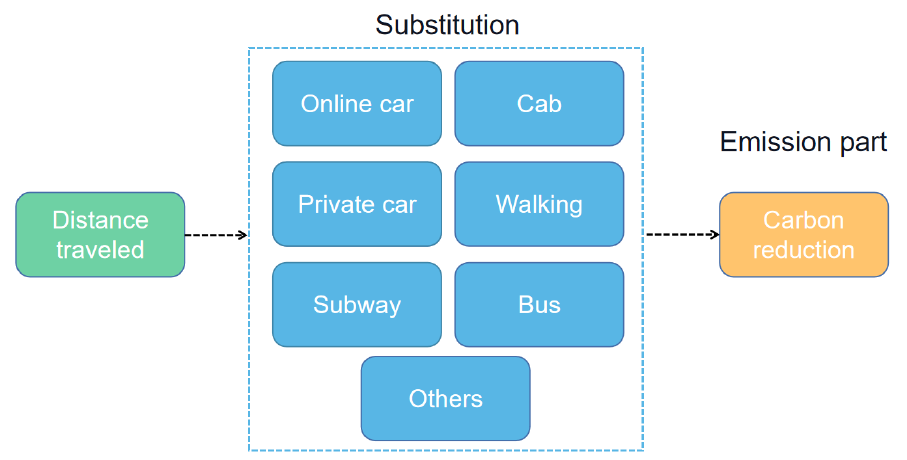
Figure 3. Substitution effect of different travel modes .